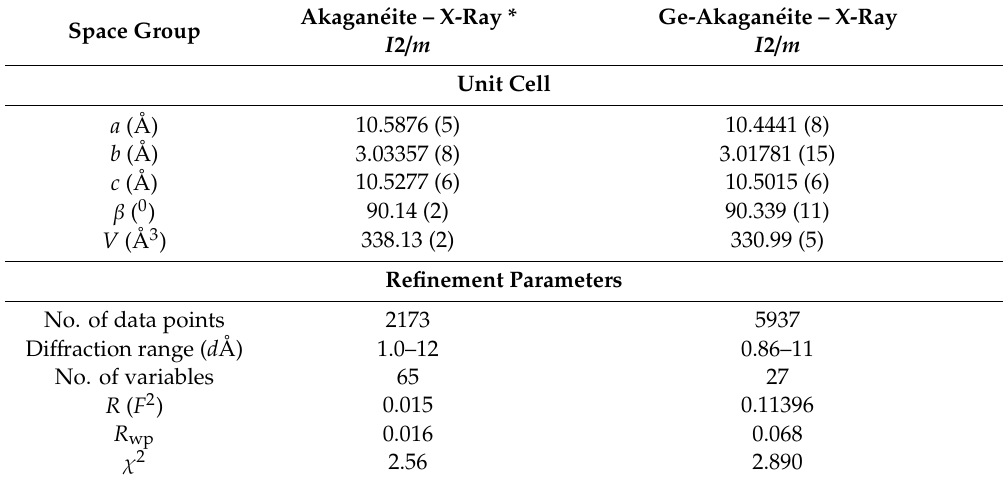
Table 1. Final refinement parameters for Ge-akagan é ite compared with those for akagan é ite and the atomic coordinates with isotropic displacement factors for Ge-akagan é ite.